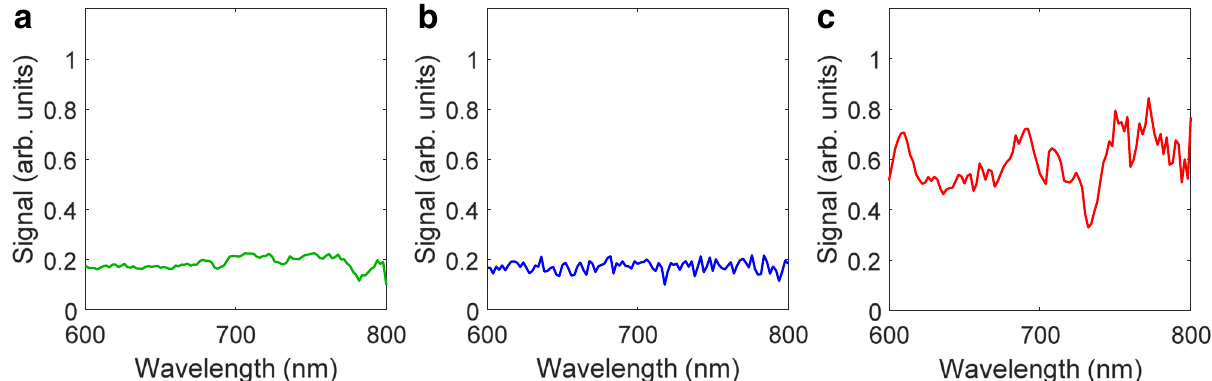
Fig.4|Singlebackscatteringspectra. TypicalsinglebackscatteringcomponentsreconstructedfromthespatiallygatedwhitelightdatacollectedwiththeLSS-DRSprobe in ( a ) benign, ( b ) in fl ammation, and ( c ) high-grade dysplasia bile duct sites.